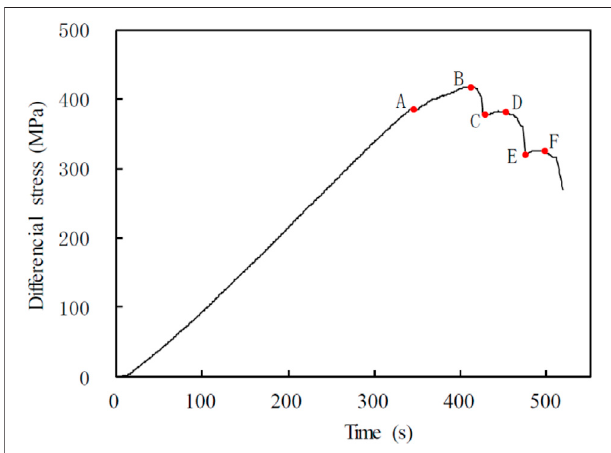
FIGURE 6 | Differential stress and strain vs. time in triaxial